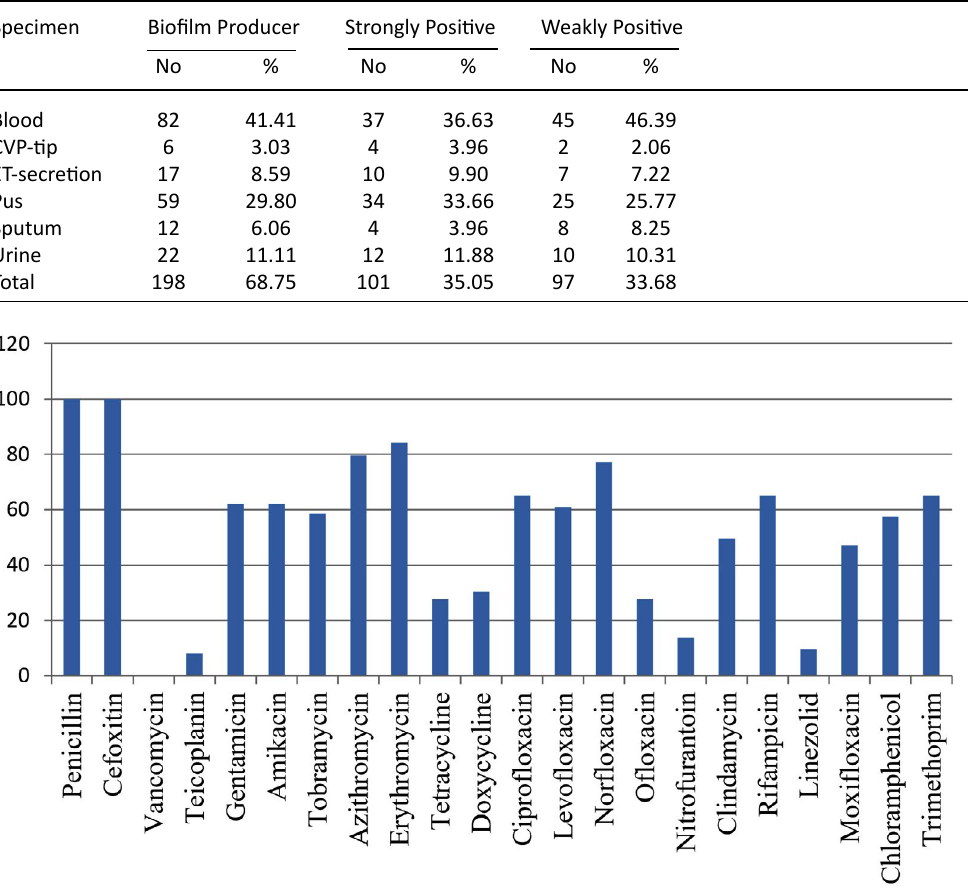
Fig. 5. Antibiotic Susceptibility Patterns of Biofilm producing